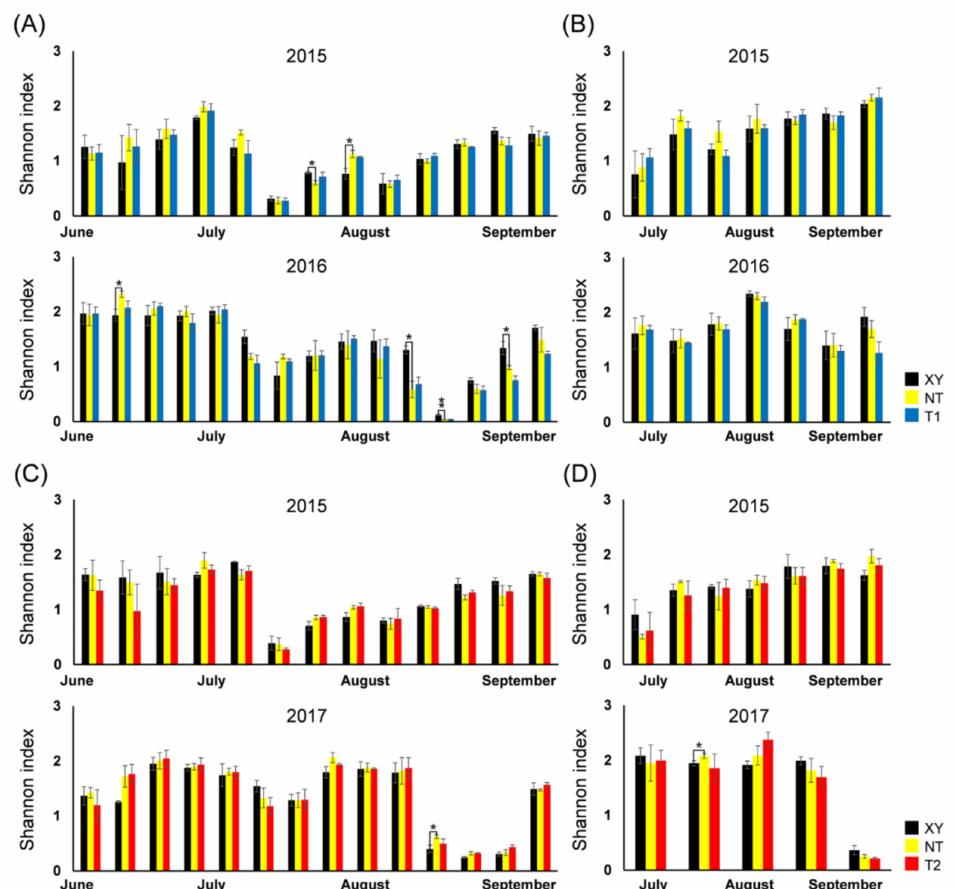
Figure 4. From 2015 to 2017, dynamics of Shannon–Wiener biodiversity index ( H ) of the arthropod community in the plots of cultivated variety XianYu335 (XY), non-transgenic recipient variety DBN318 (NT), transgenic maize DBN9868 (T1) and DBN9936 (T2). ( A ) The H of plant-inhabiting arthropods in XY, NT and T1; ( B ) the H of ground-dwelling arthropods in XY, NT and T1; ( C ) the H of